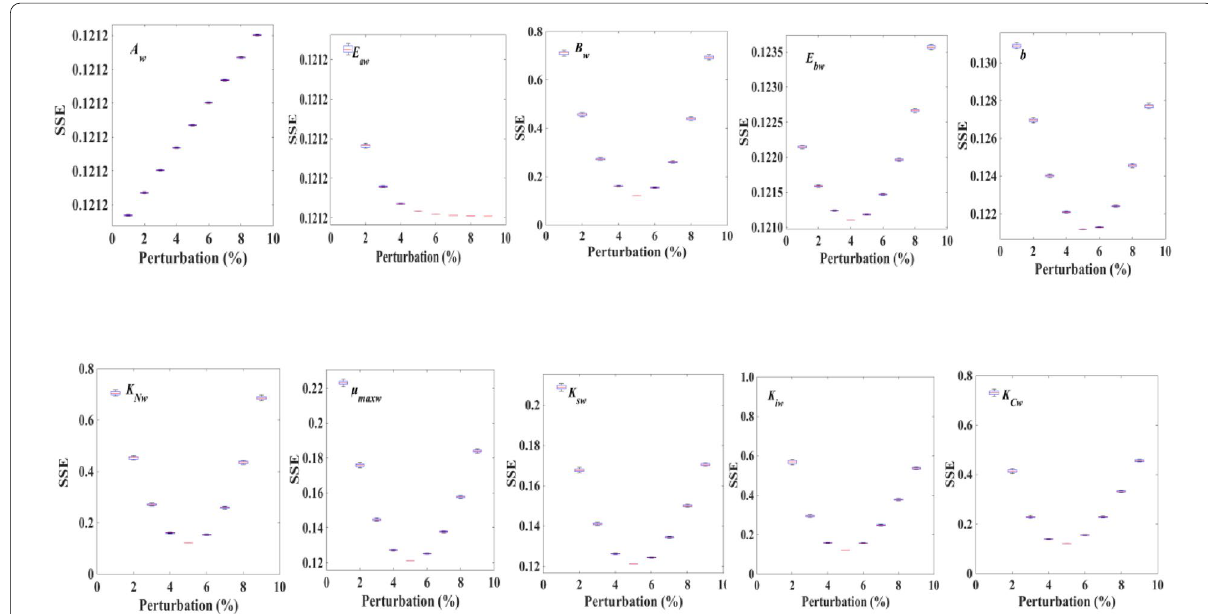
Fig. 4 Optimization of model parameters for β-carotene accumulation in D. salina (optimized by MATLAB). SSE: system squared error, where A w and B w are the coefficients before the index, E aw is activation energy of β-carotene accumulation, E bw is inactivation energy for β-carotene synthesis, b is no correlation coefficient for the growth of β-carotene production, K sw is the light saturation value of β-carotene accumulation, μ wmax is the maximum β-carotene content, K Nw is nitrate half-velocity constant for β-carotene synthesis, I av is average light intensity, K iw is β-carotene accumulation photoinhibition value, and K Cw is carbon content half-velocity constant for β-carotene synthesis